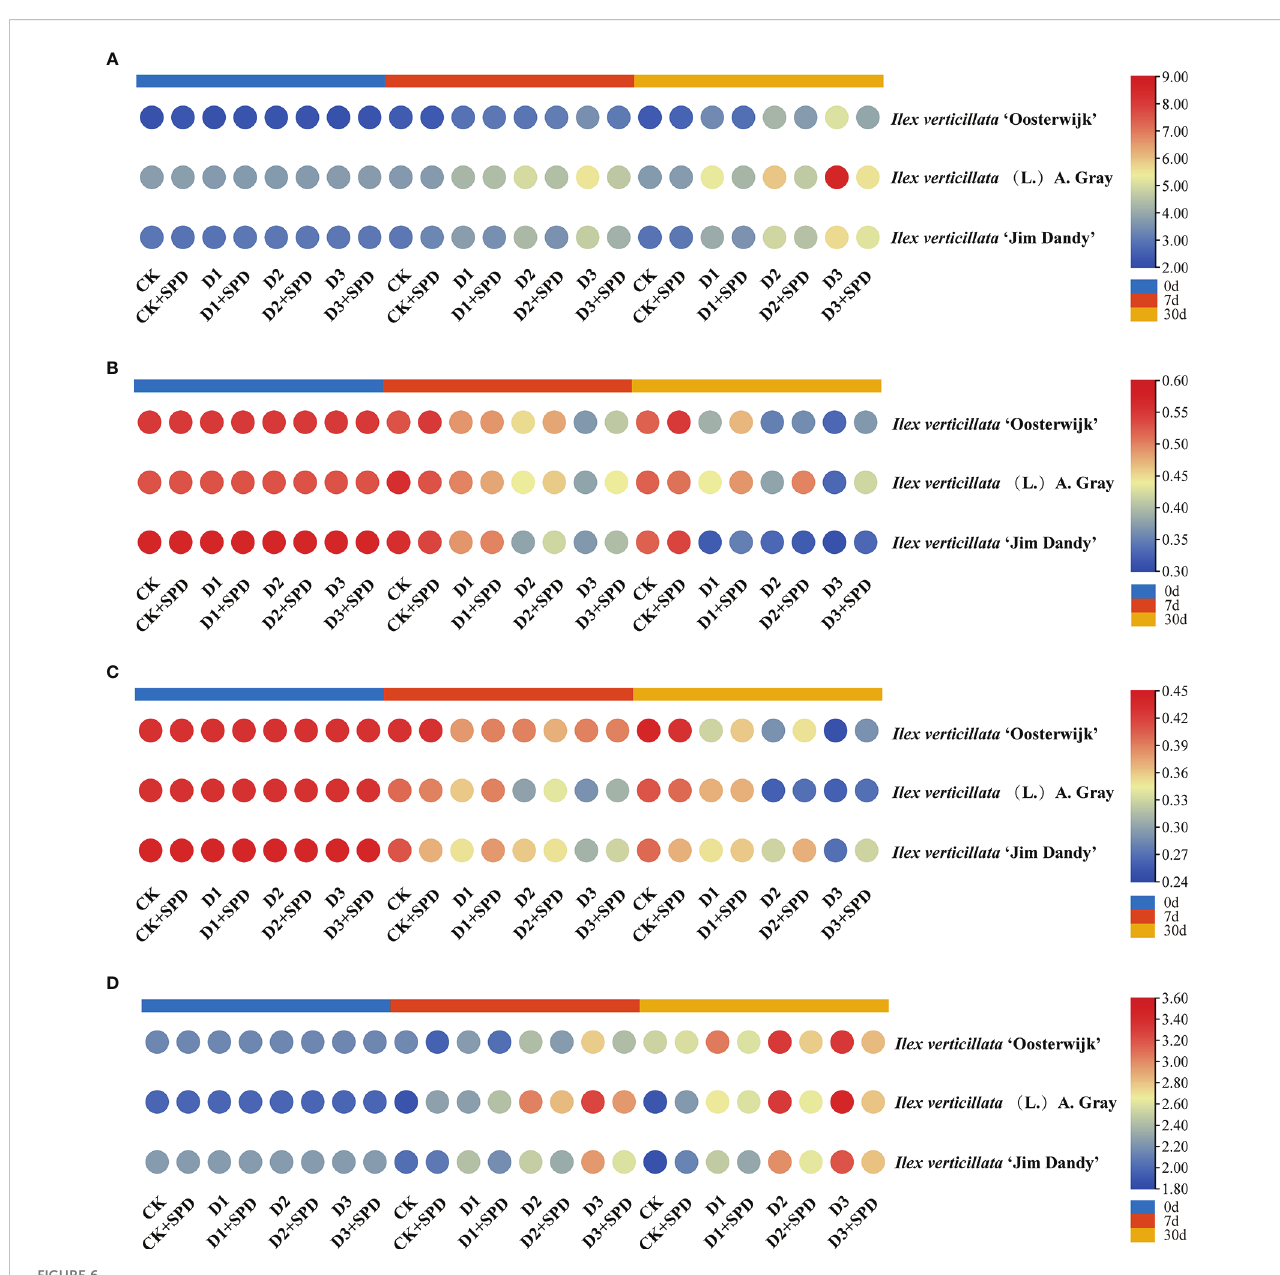
FIGURE 6 The changes of soluble sugar content and endogenous hormone contents in Ilex verticillata leaves under drought and spermidine treatment. (A) soluble sugar; (B) IAA; (C) GA; (D) ABA. Data were shown in different heatmaps, where red indicates high values and blue indicates low values. CK, control; CK +SPD, control with spermidine; D1, mild drought; D1+SPD, mild drought with spermidine; D2, moderate drought; D2+SPD, moderate drought with spermidine; D3, severe drought; D3+SPD, severe drought with spermidine. ABA, abscisic acid; GA, gibberellic acid; IAA,